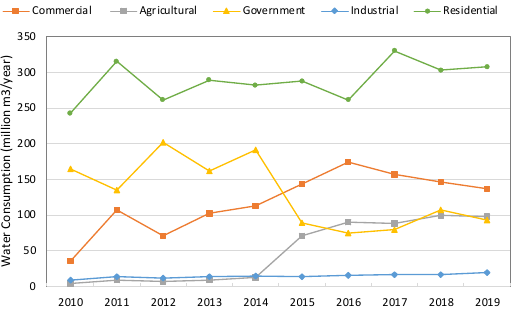
Figure 2. Water consumption by category in Abu Dhabi over time (2010–2019).